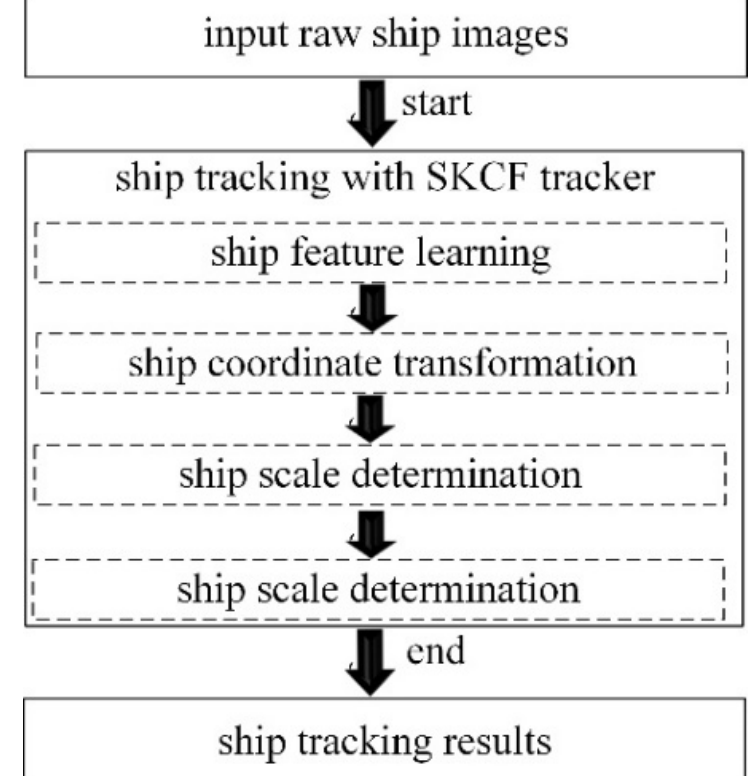
Figure 1. Flowchart of proposed SKCF tracker.